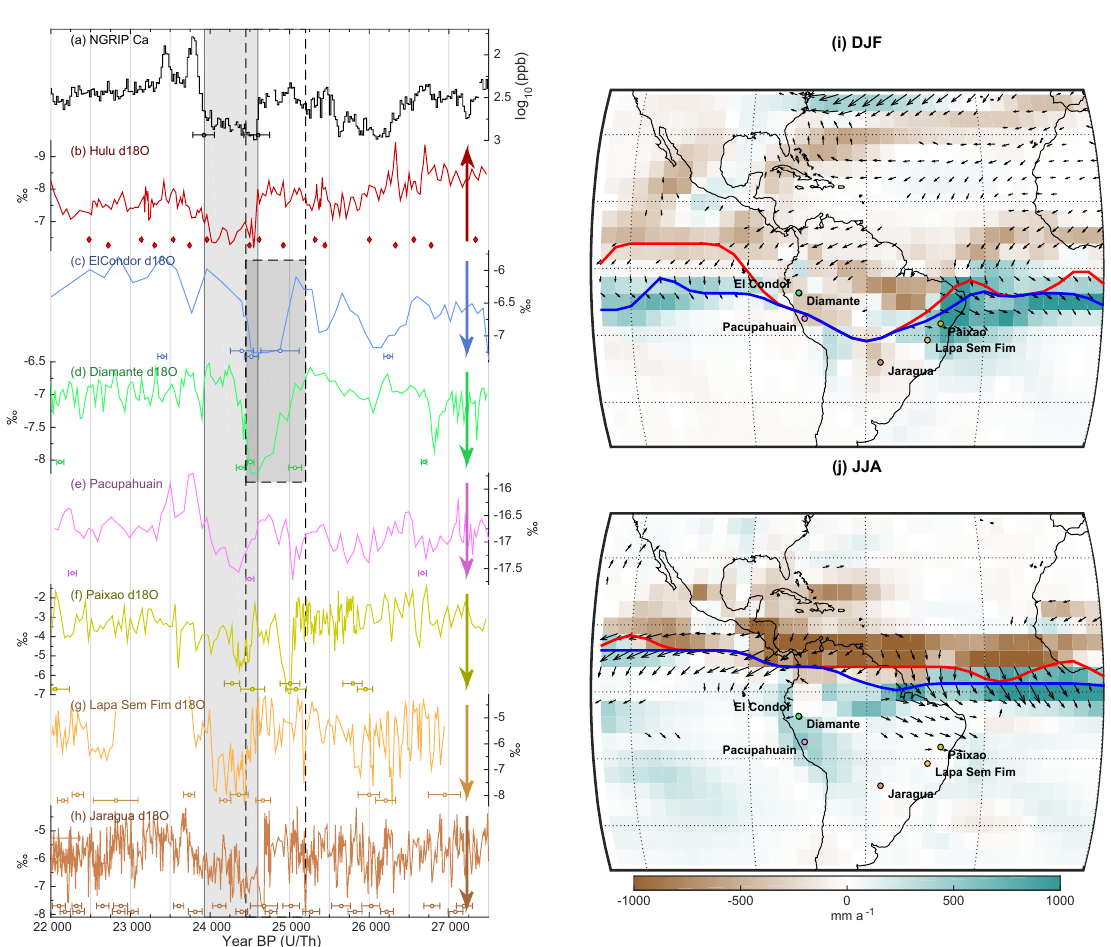
Figure 16. Climate changes around H2. (a–h) NGRIP Ca (Bigler, 2004) on the synchronized timescale (Fig. 14), Hulu Cave δ 18 O (Cheng et al., 2016), El Condor δ 18 O (Cheng et al., 2013b), Cueva del Diamante δ 18 O (Cheng et al., 2013b), (e) Pacupahuain δ 18 O (Kanner et al., 2012), Paixao δ 18 O (Stríkis et al., 2018), Lapa Sem Fim δ 18 O (Stríkis et al., 2018), and Jaragua Cave δ 18 O (Novello et al., 2017). The arrows on the right-hand side of each axis point in the direction of the signature of increased precipitation on δ 18 O through the amount effect (Dansgaard, 1964). The light grey box marks H2. The dark grey box highlights the preceding δ 18 O anomaly in El Condor and Diamante caves. (i, j) Precipitation (color) and wind (arrows) response to freshwater forcing in the CCSM3 climate model (freshwater-only experiment of TraCE21k, all other forcings are held at 19kaBP conditions; He, 2011). The red (blue) line depicts the latitude of the precipitation maximum during strong (weak) AMOC states. Only wind anomalies >1ms − 1 are plotted. The cave sites are indicated as dots. Panel (i) shows the winter (December–February) response, while panel (j) shows the summer (June–August) response. Anomalies are plotted as weak–strong AMOC